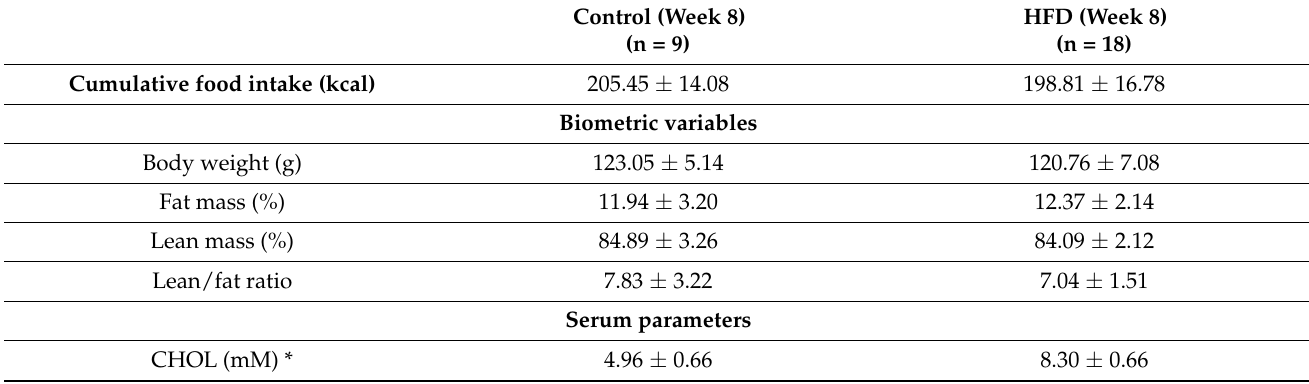
Table 1. Energy intake, body composition, and serum parameters of hamsters fed with a NFD (CTRL group) or a HFD (HFD group) in the 8th week of the